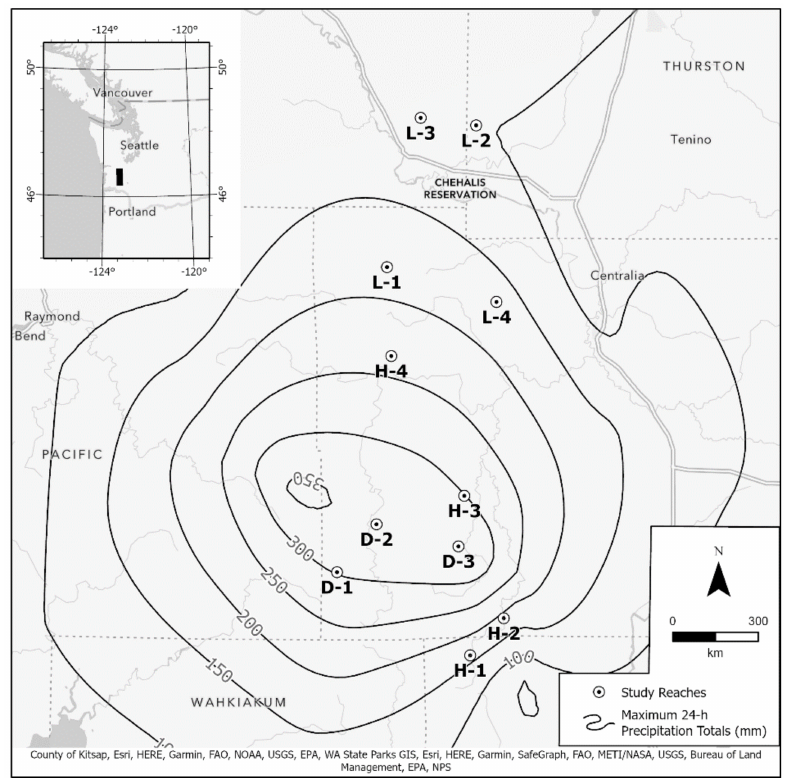
Figure 1. Study reaches and maximum 24-h precipitation totals during 1–4 December 2007. Distur-